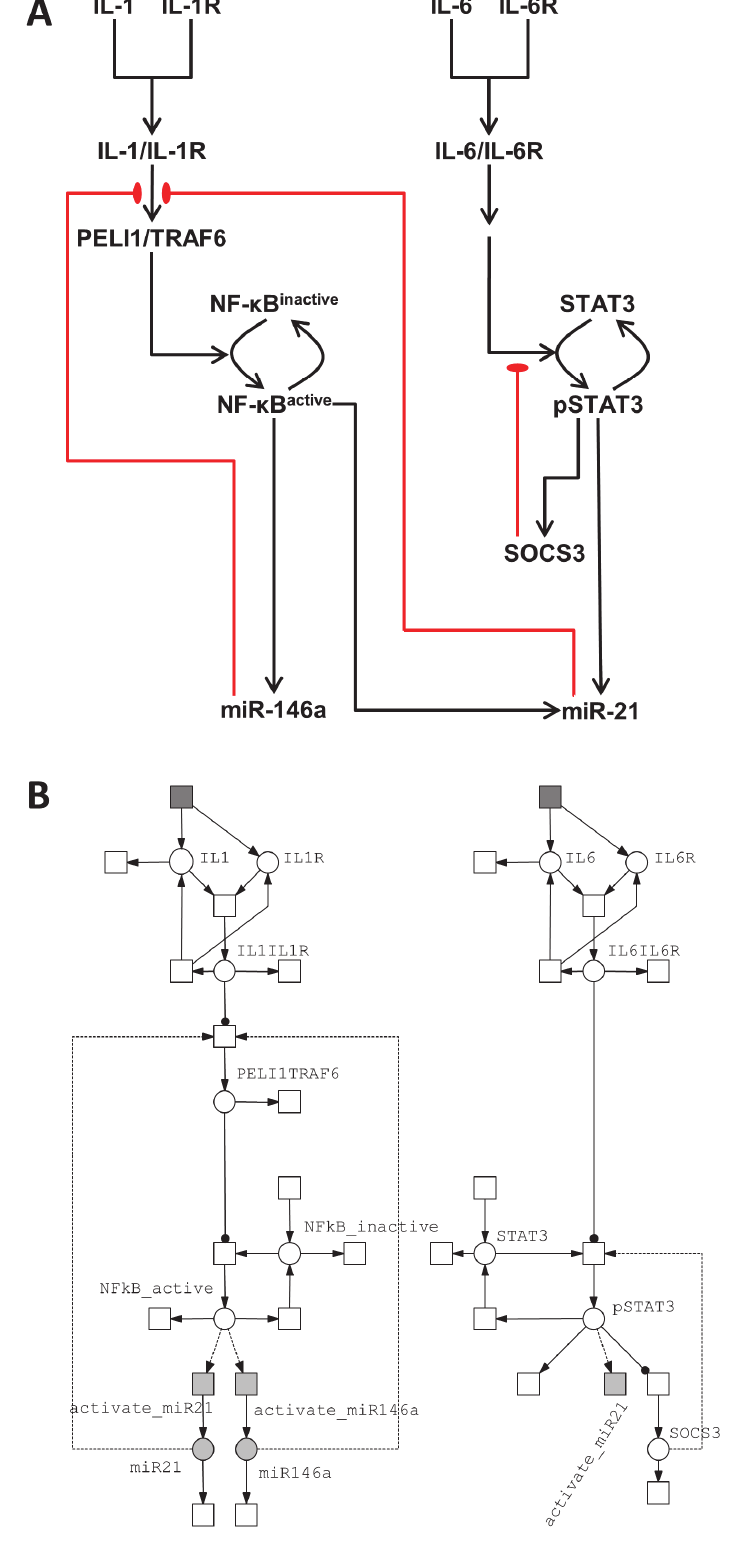
Figure A2. Schematic ( A ) and Petri net ( B ) representations of the IL-1/NF- κ B and IL-6/STAT3 network simulated in Figure